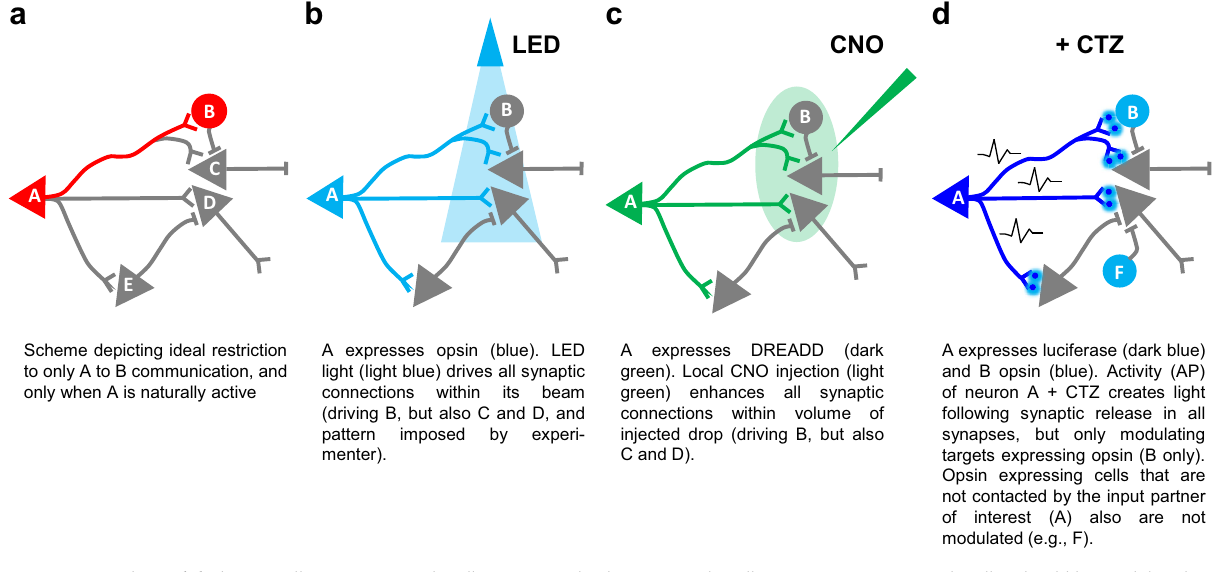
Fig. 1 Transsynaptic modulation. a Cell A connects with cells B, C, D and E; however, only cell A ’ s communication with cell B should be modulated, either ampli fi ed or dampened. b If cell A expresses optogenetic actuators, restriction of a light beam to the area of intended synaptic transmission can minimize unwanted activation (cell E will not be activated), but the likelihood of still activating unwanted synapses (cells C and D) is high. c The same applies when expressing a chemogenetic actuator (DREADD, designer receptor exclusively activated by designer drugs) in cell A and restricting application of the ligand CNO ( Clozapine -N-Oxide) to an anatomical area as small as possible. d True cell-to-cell synaptic communication can be achieved by expressing a luciferase in cell A and an opsin in cell B. Activity of neuron A and application of the luciferin CTZ (Coelenterazine) results in light emission at all synapses of A, but only the opsin-expressing cell B will be modulated. At the same time, opsin-expressing cells not synaptically contacted by the luciferase-expressing cell A will not be